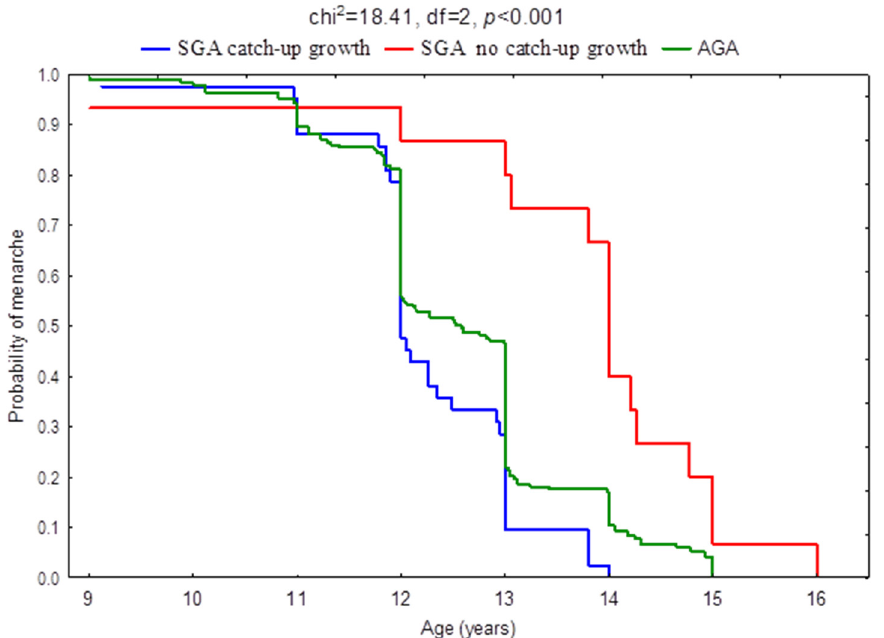
Figure 2. Kaplan–Meier curves applied to the age at menarche in girls born small for gestational age (SGA) with catch-up growth, in girls born small for gestational age (SGA) without catch-up growth, and in girls born appropriate for gestational age (AGA).